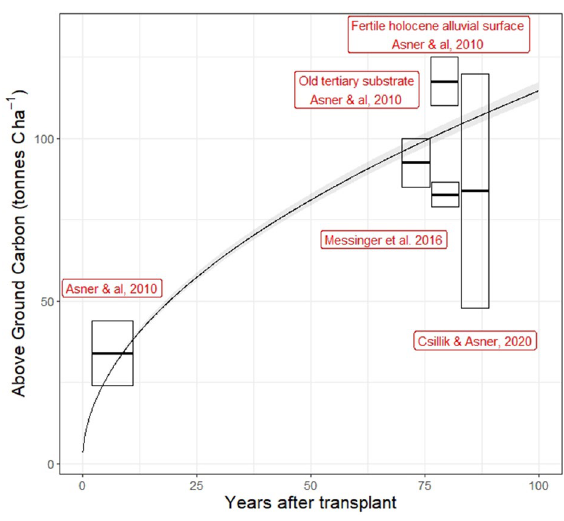
Figure 4. Above-ground carbon model (black line) and boxes representing above-ground carbon values from the literature of forest plot nearby our case study. Forest plots represented by the boxes on the right hand side were assumed to be a mature forest (≈ 80 years) 2,33,41,42